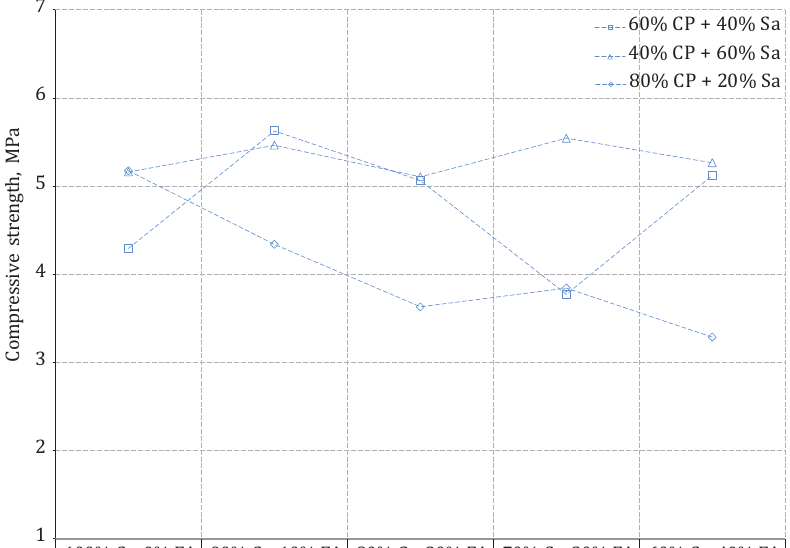
Figure 7. Fly ash effect on strength after 548 days